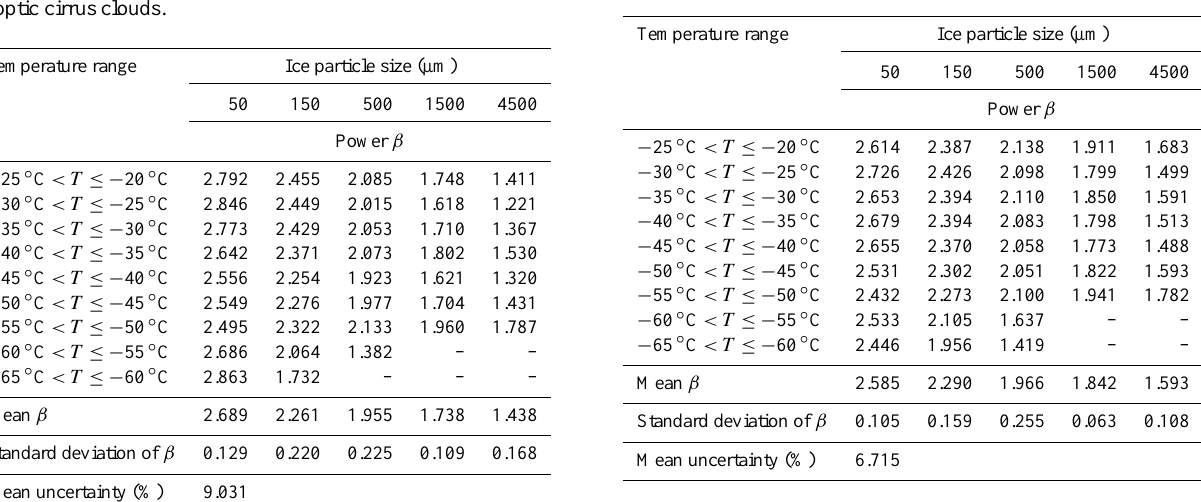
Table 4. Same as Table 3 but for anvil cirrus